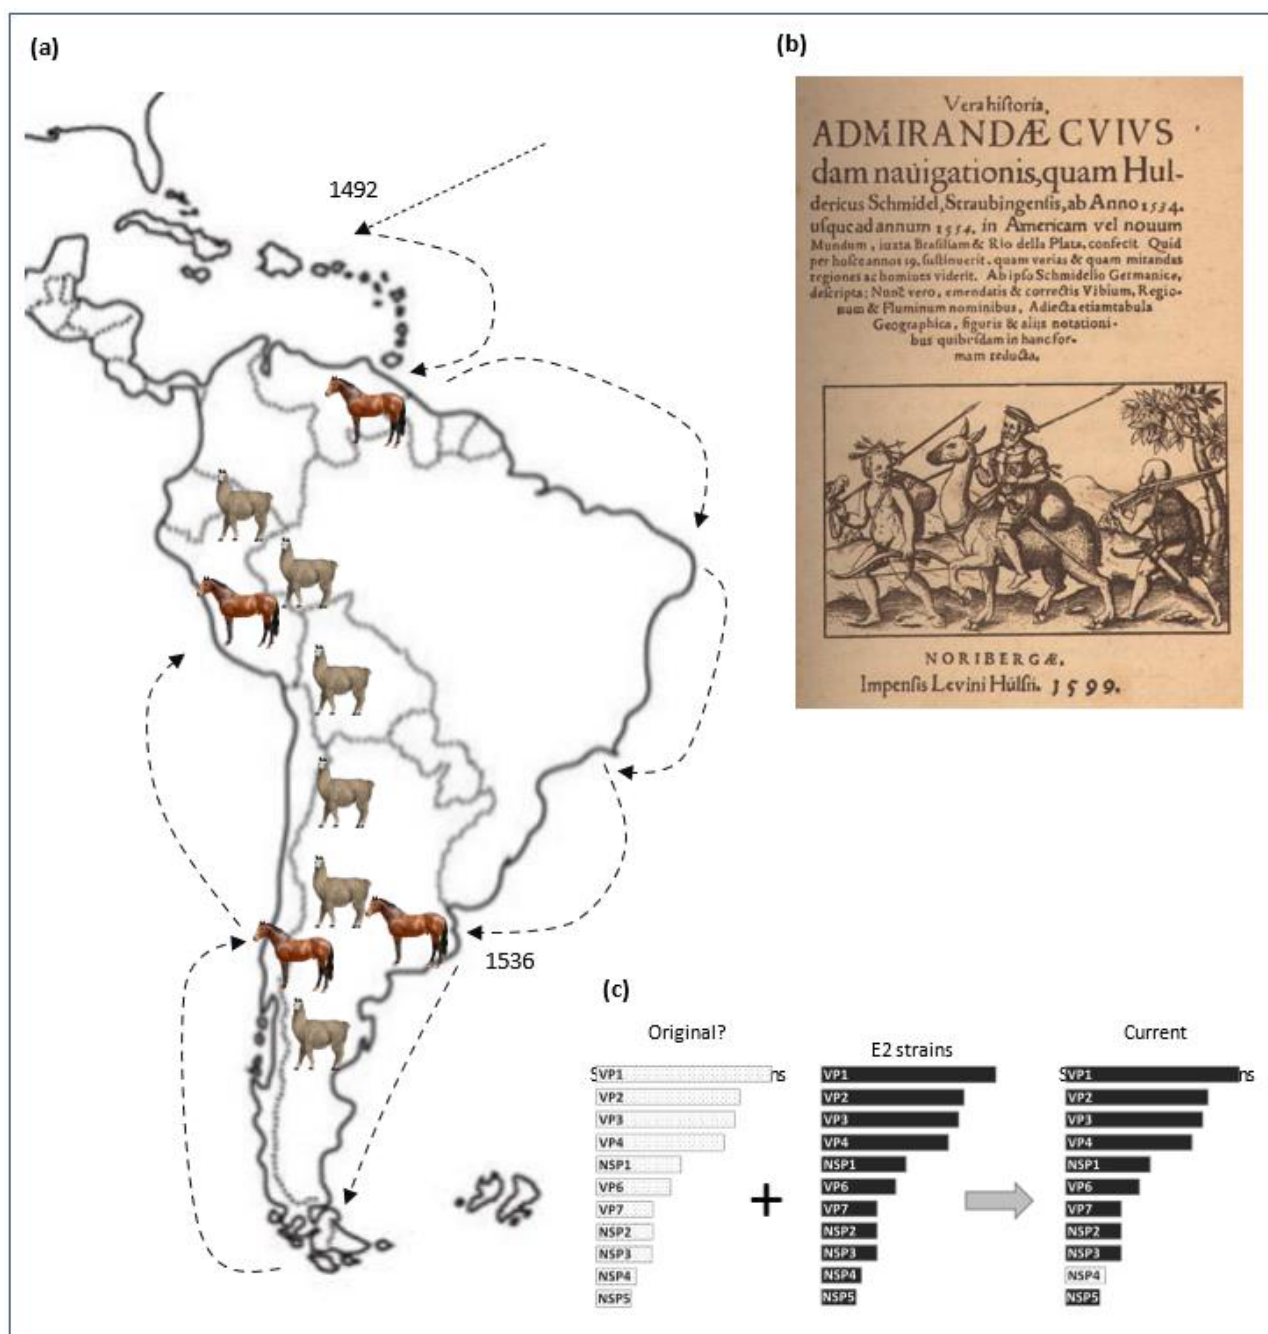
Figure 2. ( a ) The map shows the route followed by the Spanish including Pedro de Mendoza since the conquest of America. The numbers indicate the date of the foundation of the city (Buenos Aires: 1536; Santiago de Chile: 1541). The places where cows and horses were released are indicated by figures of horses. The territory occupied by wild guanacos is indicated with small figures of guana- cos. ( b ) The diary of Mr. Schmidel, survivor of the expedition of 1534, showed Pedro de Mendoza riding a guanaco. Considering that Pedro de Mendoza died shortly after the expedition began, one could propose that he encountered the guanacos in Buenos Aires. ( c ) Hypothesis of the possible origin of the E12 gene is explained as a gene substitution event.